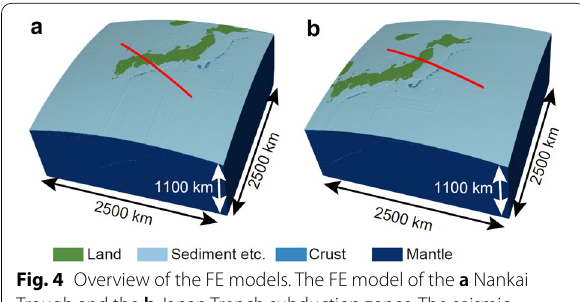
Fig. 4 Overview of the FE models. The FE model of the a Nankai Trough and the b Japan Trench subduction zones. The seismic velocity profiles on the red lines are shown Fig.